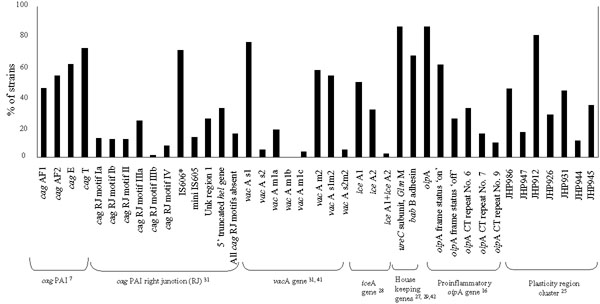
Diagram showing the percent distribution of different genetic loci in the English isolates. The presence of the cag PAI with the motifs on its right end, the vacA and iceA genotypes and the presence of the glmM and babB house keeping genes and characteristics of the virulence gene oipA and the genes included in the plasticity region cluster are shown. The distribution was determined by PCR using primer sequences from the reference articles denoted by the number in superscript.